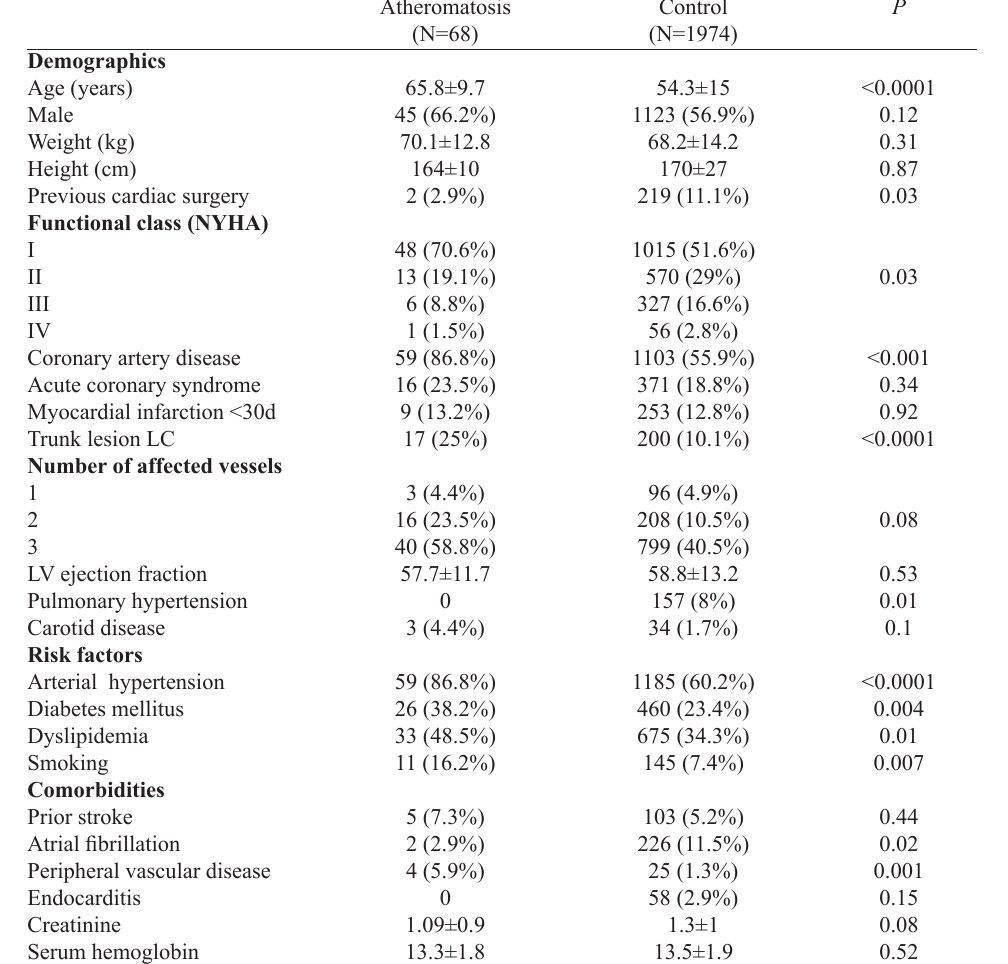
Table 1. Preoperative characteristics of patients with and without atheromatous aorta who underwent cardiovascular